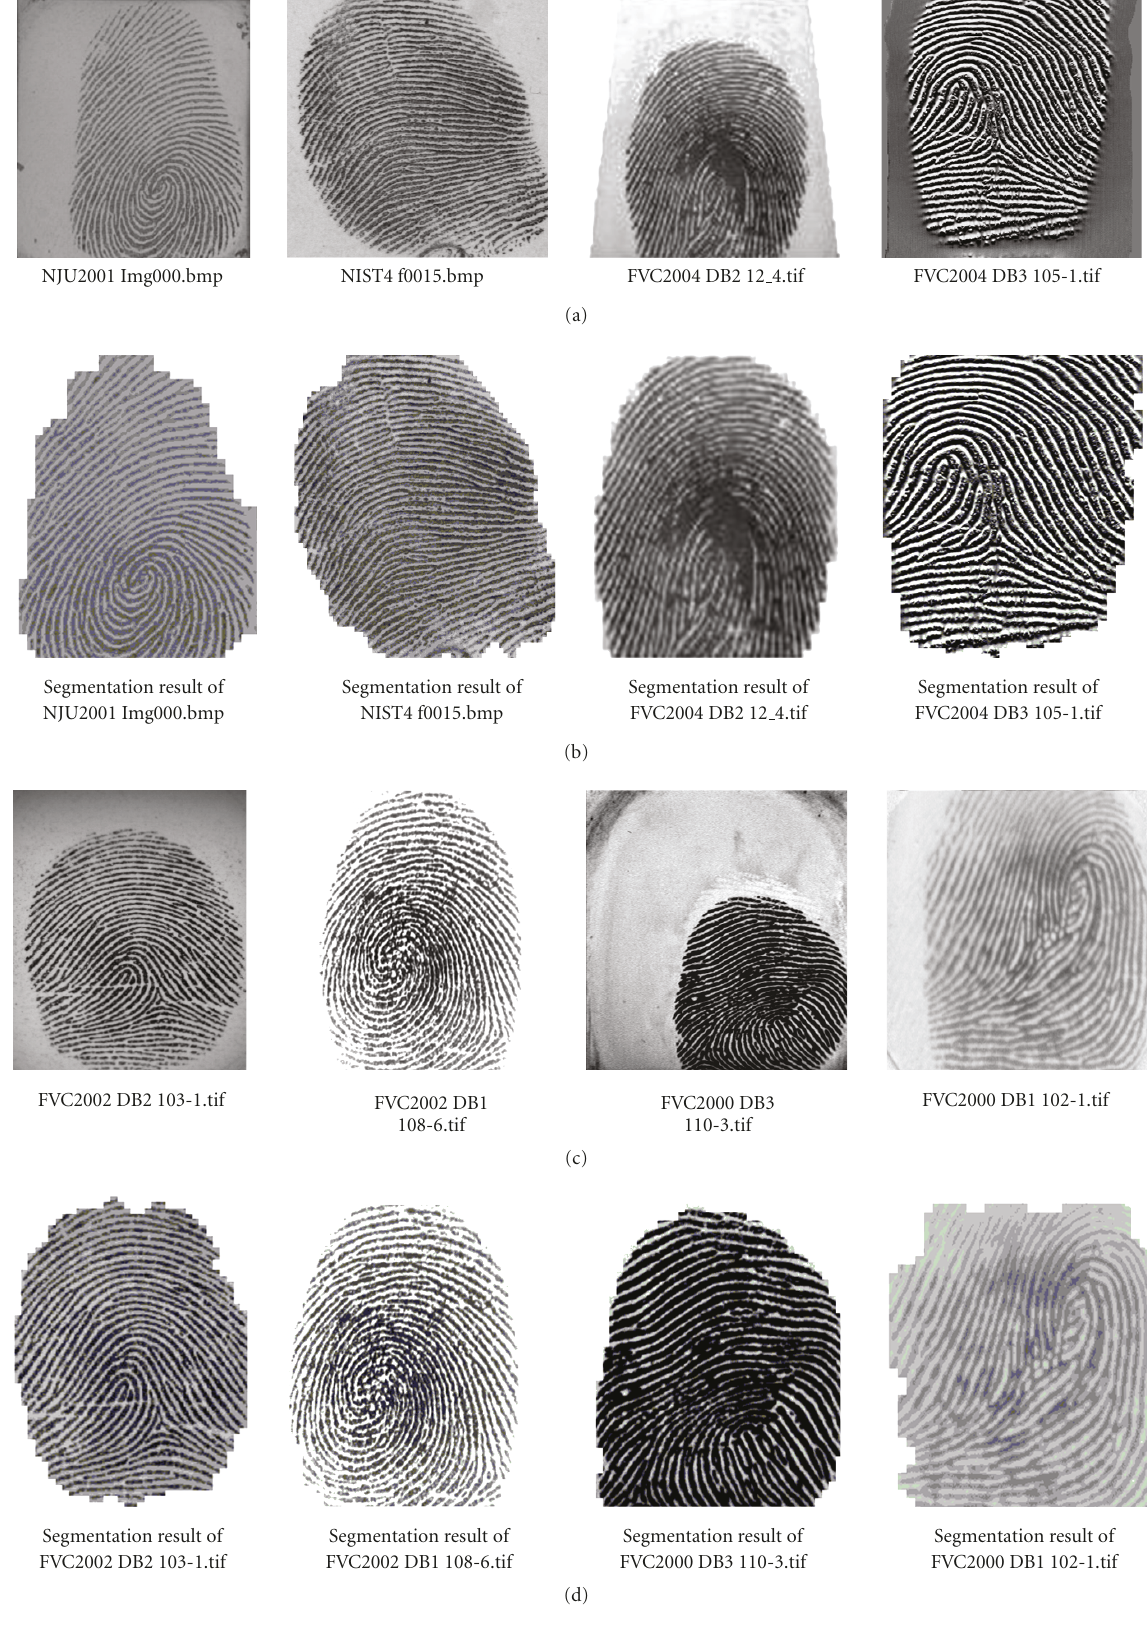
Figure 8: Sample segmentation results of